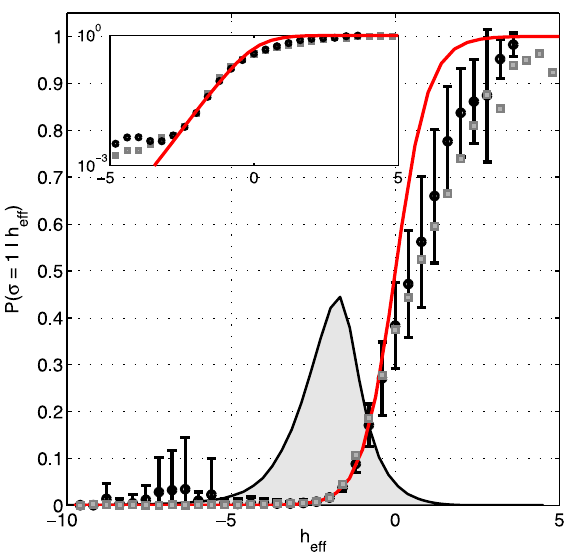
Figure 9. Effective field and spiking probabilities in a network of N =120 neurons. Given any configuration of N { 1 neurons, the K- pairwise model predicts the probability of firing of the N -th neuron by Eqs (25,26); the effective field h eff is fully determined by the parameters of the maximum entropy model and the state of the network. For each activity pattern in recorded data we computed the effective field, and binned these values (shown on x-axis). For every bin we estimated from data the probability that the N -th neuron spiked (black circles; error bars are s.d. across 120 cells). This is compared with a parameter-free prediction (red line) from Eq (26). For comparison, gray squares show the analogous analysis for the pairwise model (error bars omitted for clarity, comparable to K-pairwise models). Inset: same curves shown on the logarithmic plot emphasizing the low range of effective fields. The gray shaded region shows the distribution of the values of h eff over all 120 neurons and all patterns in the data.